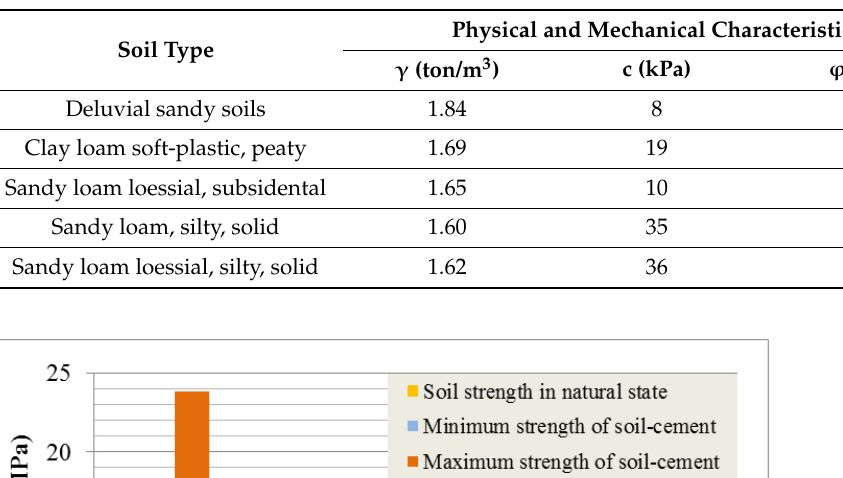
Table 2. Physical and mechanical characteristics of the soil in which jet-grouting was applied.